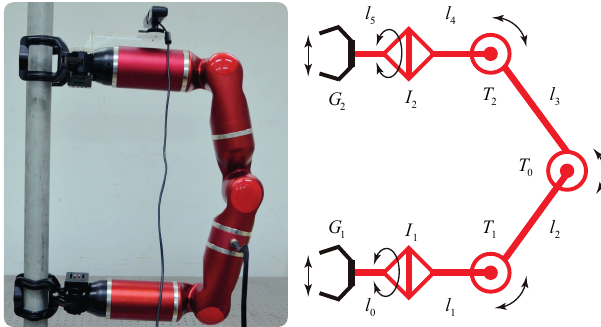
Figure 2. Climbot and its kinematic